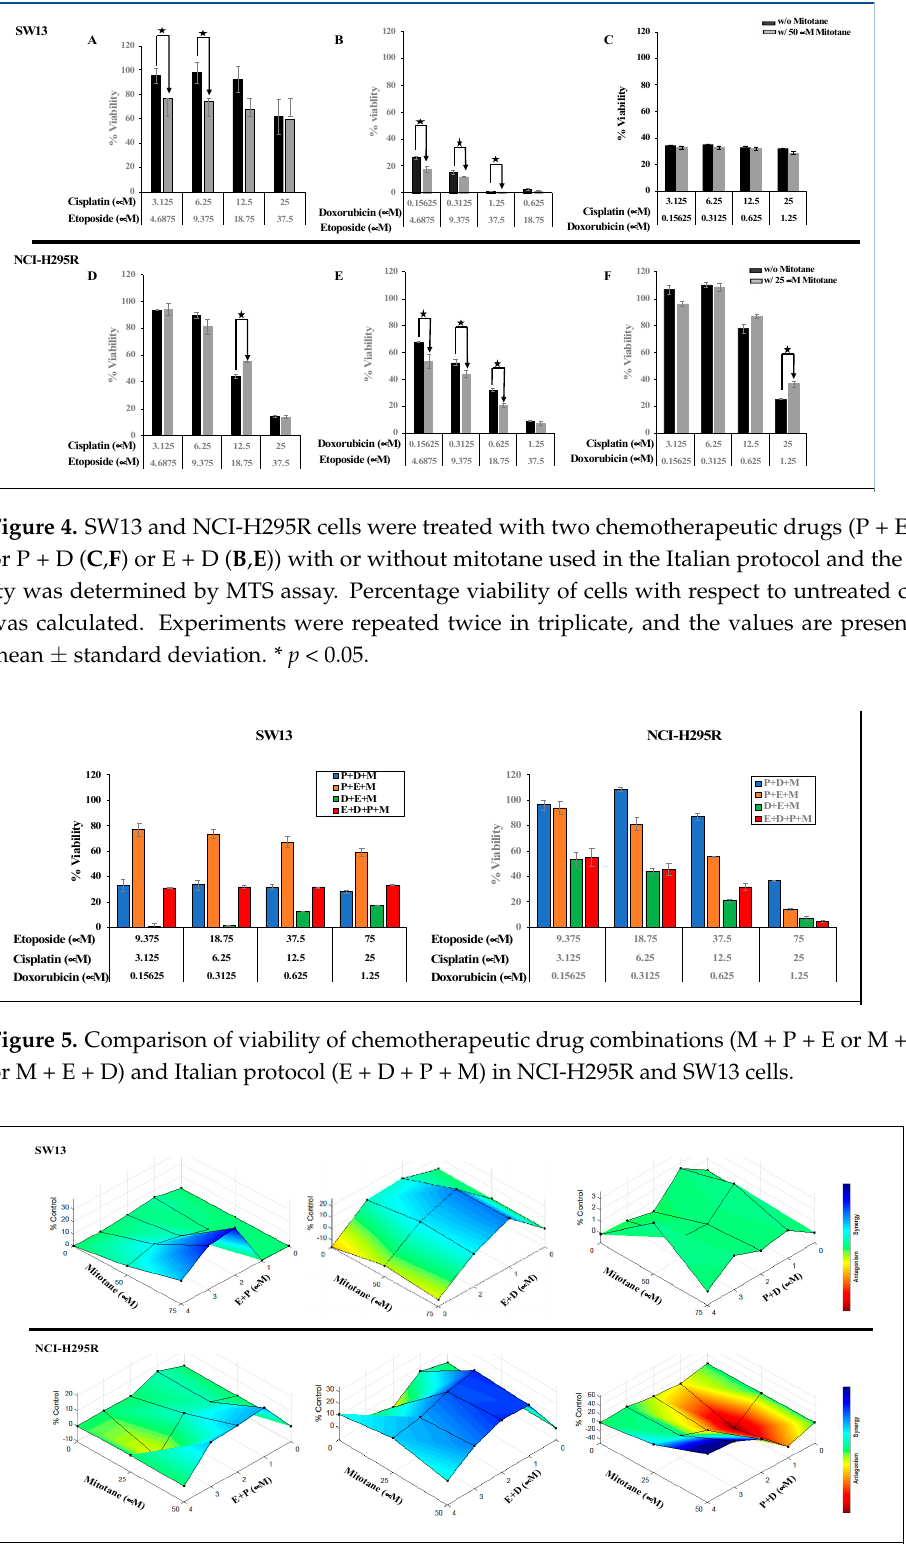
Figure 6. Combenefit analysis showing synergistic combinations of mitotane with combinations of chemotherapeutics (M + P + E or M + P + D or M + E + D) in Italian protocol. Surface maps of combination effects plotted using Combenefit software illustrating color coded maps for synergis- tic/antagonistic